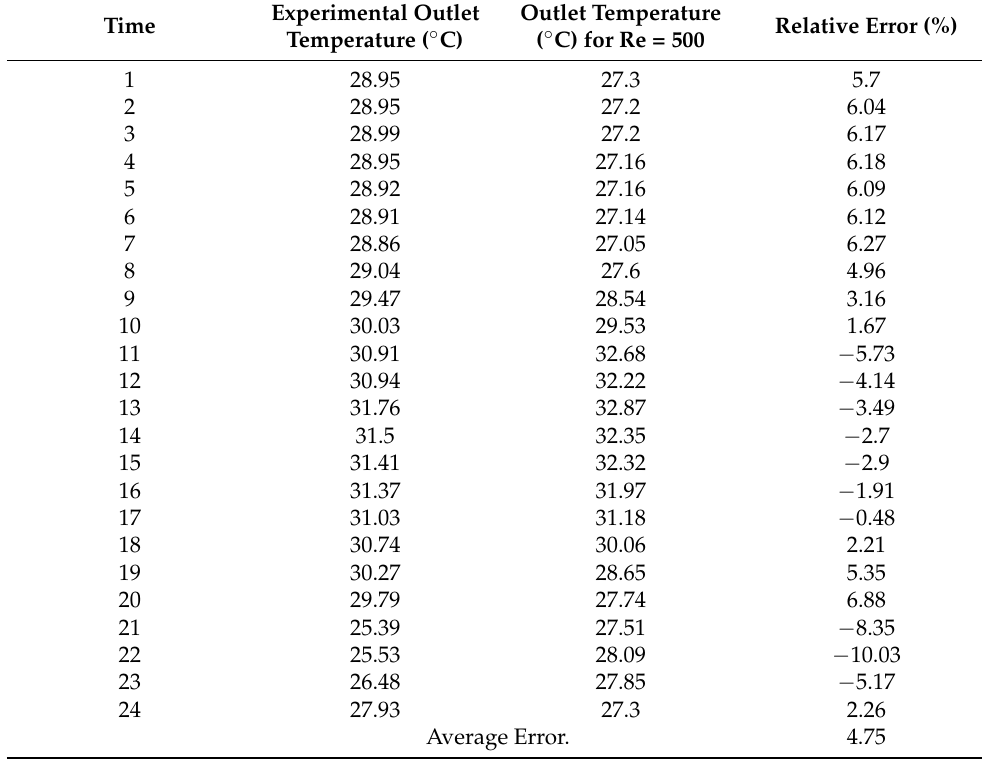
Table 6. Comparison of experimental vs modeled outlet temperature for 30 July 2016 (2 m depth).